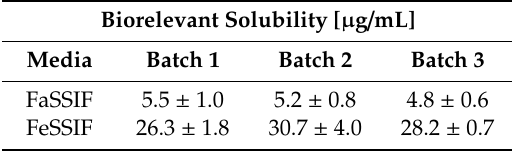
Table 2. Biorelevant solubility of venetoclax at 37 ◦ C (mean ± SD; n = 3).